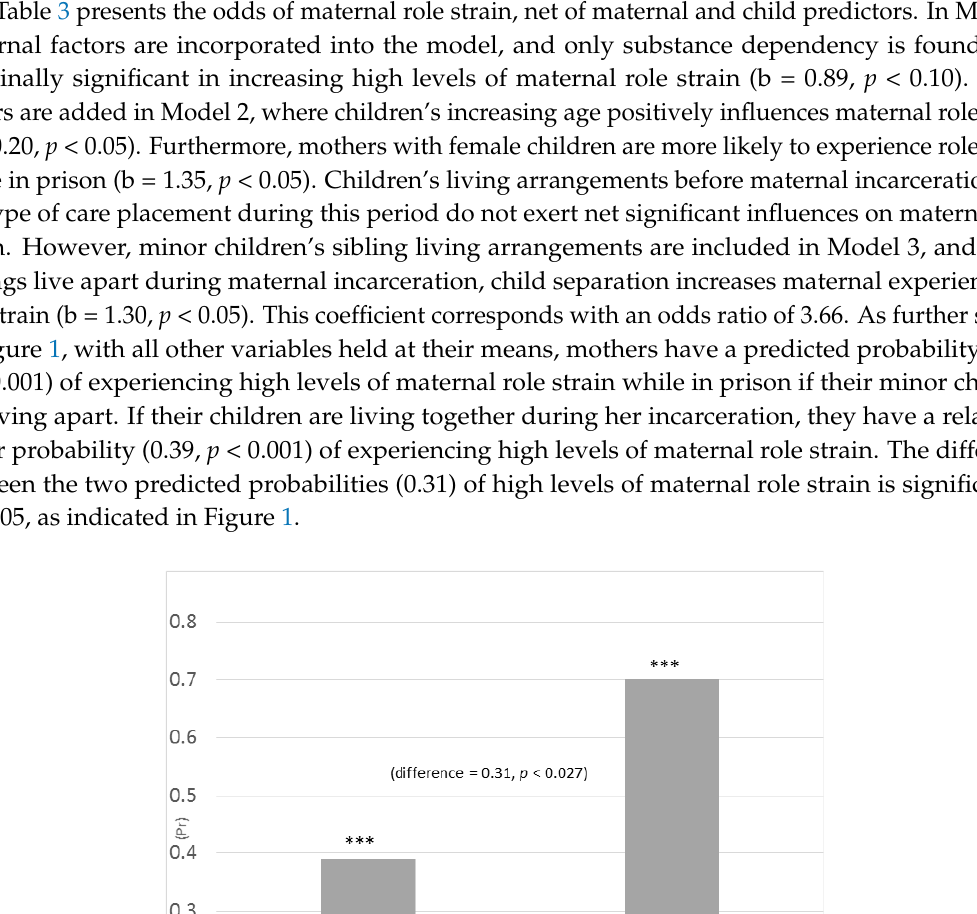
Table 3. Logistic regression of maternal role strains on siblings living apart during maternal incarceration net of maternal and child factors.